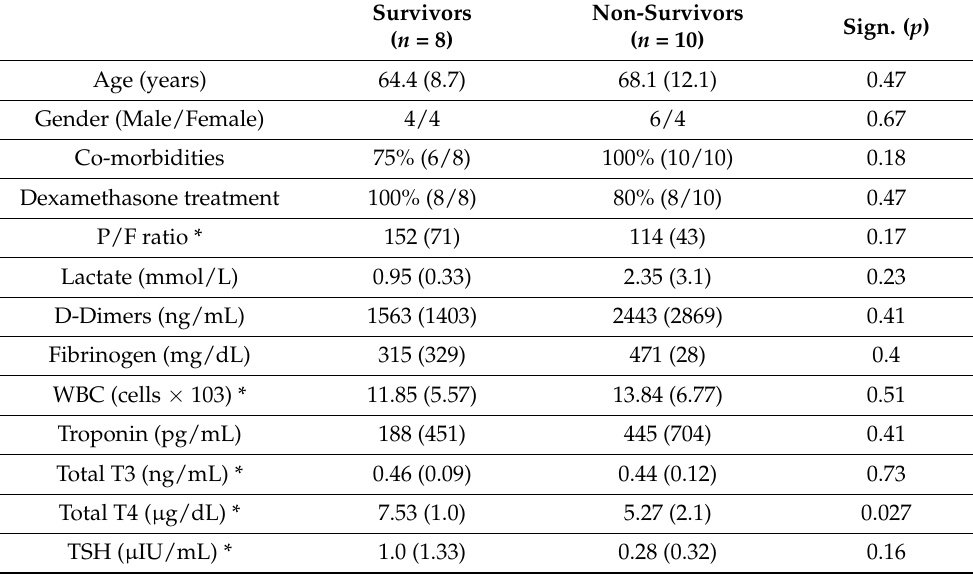
Table 1. Thyroid hormone levels and other parameters of critically ill COVID-19 patients at the first day of admission in ICU. Data were collected during screening for the pilot RCT Thy-Support. Survivors Non-Survivors Sign. ( p ) ( n = 8) ( n = 10) Age (years) 64.4 (8.7) 68.1 (12.1) 0.67 Co-morbidities 75% (6/8) 0.18 Dexamethasone treatment 100%